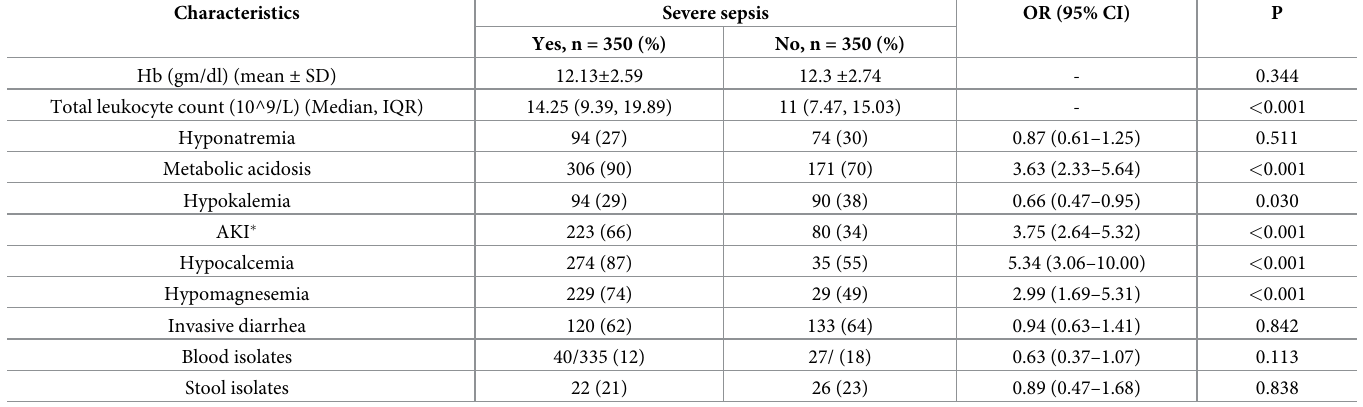
(69%) patients developed septic shock and required inotropes (Table 1). Regarding the comor- bidities among cases, 20.9%, 12%, and 6.3% had chronic lung diseases, Diabetes Mellitus, and arthritis respectively. Table 2. Laboratory characteristics of diarrheal patients with and without severe